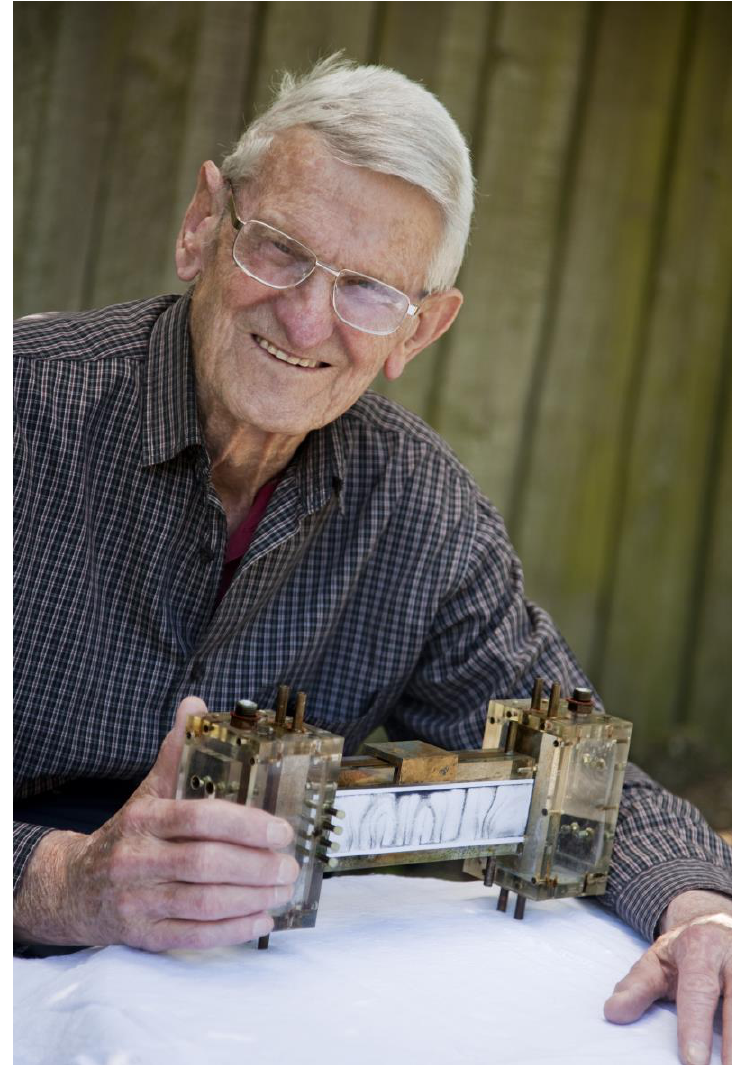
Figure A1. John W. Elder with the actual Hele-Shaw cell apparatus he used for his experiments at Cambridge in 1967 (Photo taken 5 January 2017).